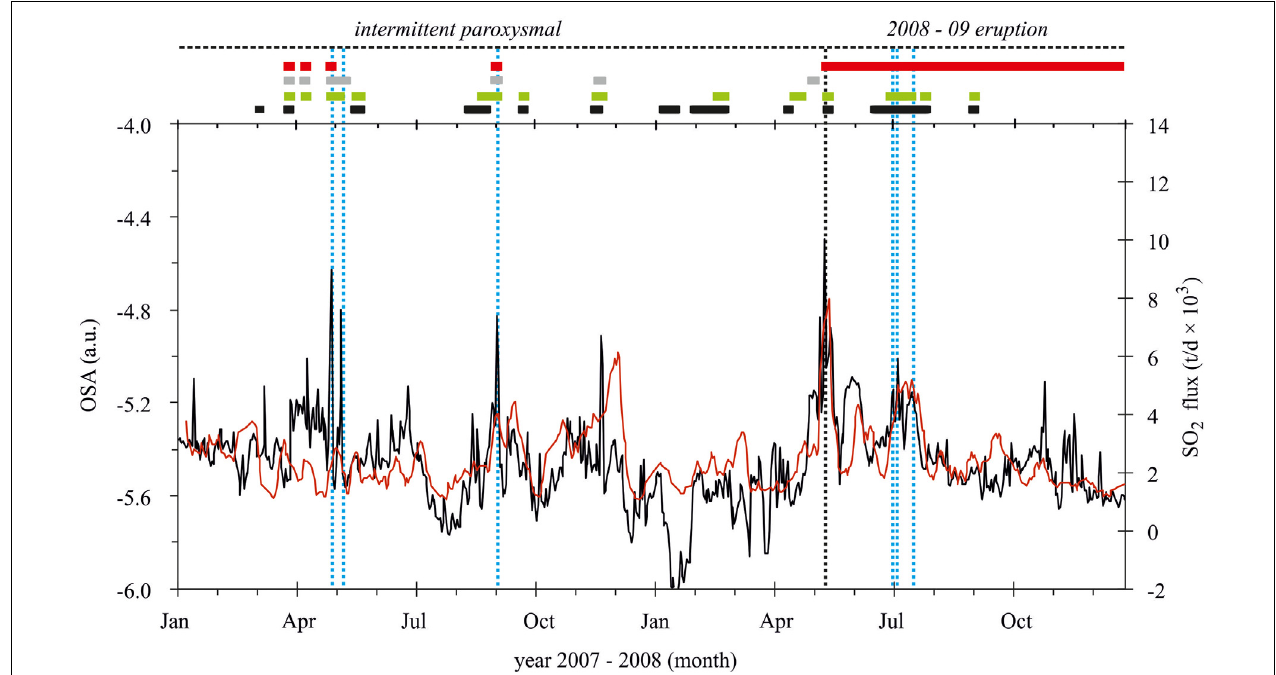
FIGURE 2 | Weekly averaged SO 2 flux (in red) and daily averaged overall spectral amplitude (OSA) of the volcanic tremor (in black) in 2007 and 2008; tremor is represented on a logarithmic. The black-dashed vertical line between April and July 2008 indicates the start of the 2008-09 eruptive activity on 13 May while the blue-dashed lines indicate the selected case studies explored at intraday scale. The upper graph shows the summary of the eruptive activity of Mt. Etna in the studied period. The 2-year long time window can be splitted into two phases according to the eruptive activity observed at the surface. The first phase relates to an intermittent paroxysmal phase consisting of ash emission (black square), strombolian activity (green-square), lava fountaining (gray-square), and lava emission (red-square), the second phase refer to a period characterized by persistent lava emission and irregular moderate strombolian explosions and ash emissions along the 2008-09 eruptive fissure. Uncertainty in SO 2 flux by stationary array arise from several sources, such as wind-plume transport speed, plume height and radiative transfer, these parameters maybe highly variable being the flux affected by and uncertainty that may ranges between –22 and 36, up to 100% in challenging condition. Uncertainty in daily RMS depends on the intraday variability of the seismic averaged signal and it ranges between 10% for the intraday study and mean of 25% for the daily long-term